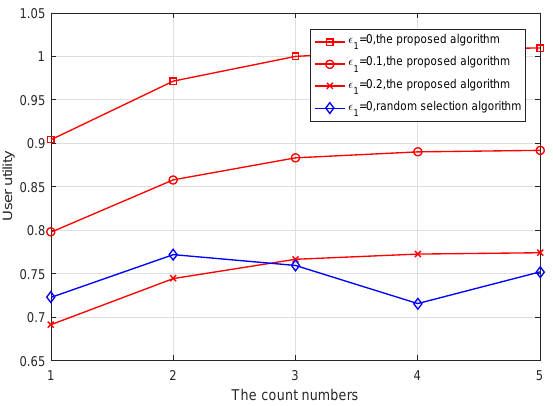
Figure 7. User’s utility comparison under different algorithms with feedback error.